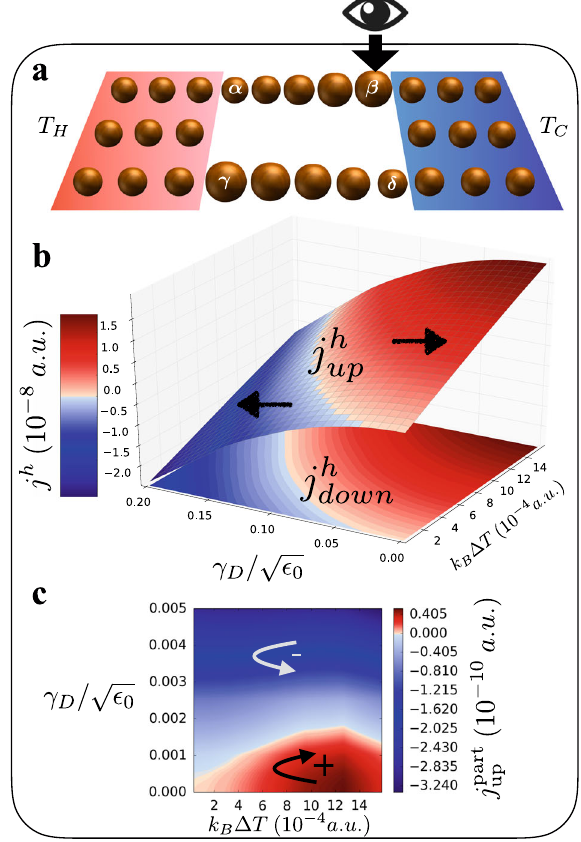
Fig. 3 In fl uence of a quantum observation on the thermo-electric fl ows in a quantum ratchet. b Change of the energy currents in the (cid:1) (cid:3) (cid:4) (cid:5) and bottom j h branches due to the in fl uence of a top j h up down local measurement on site β . c The particle current in the upper branch can be seen. It is striking in c that the particle ring-current can change direction as a function both of γ D and Δ